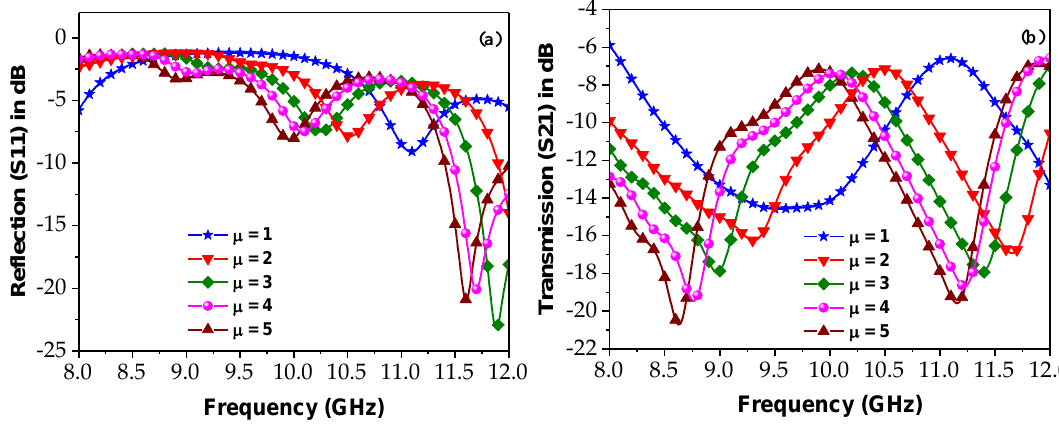
Figure 9. ( a ) Simulated variation effect of permeability of the sensor layer on the resonant frequency in the reflection and ( b ) transmission spectra.